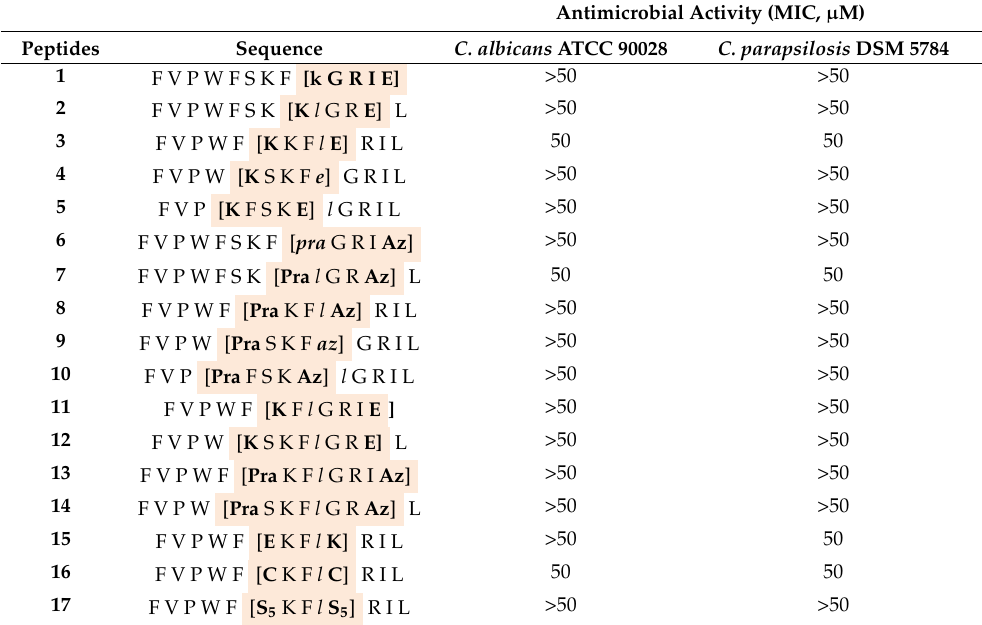
Table 1. Sequences of α -helical stapled peptides 1–17 [31]. The bridge involving the positions i,i + 4 or i,i + 7 is highlighted in green. Minimum inhibitory concentrations (MICs) of all peptides were determined on C. albicans and C. parapsilosis strains.